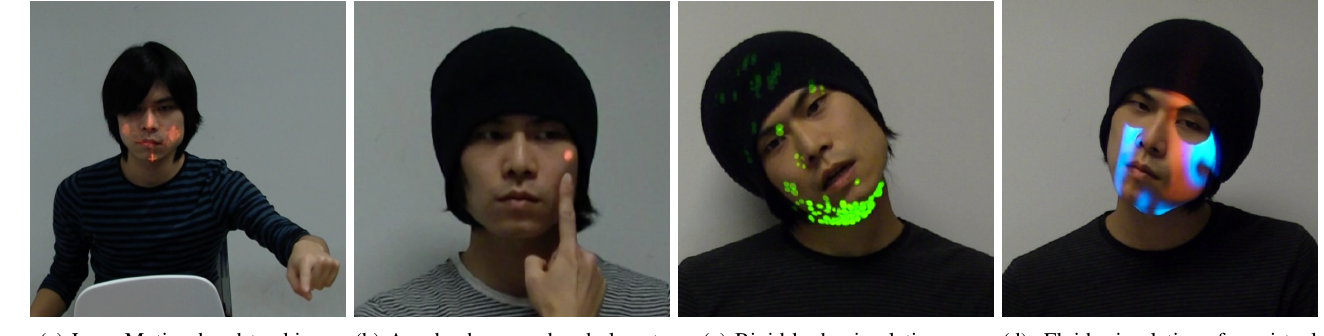
Fig. 5. Photos of the improved face projection system. In Figure 5a and 5b, finger tracking methods are integrated to possibly assist drawing on the own face. In Figure 5c and 5d, 2D physics engines are applied to render virtual